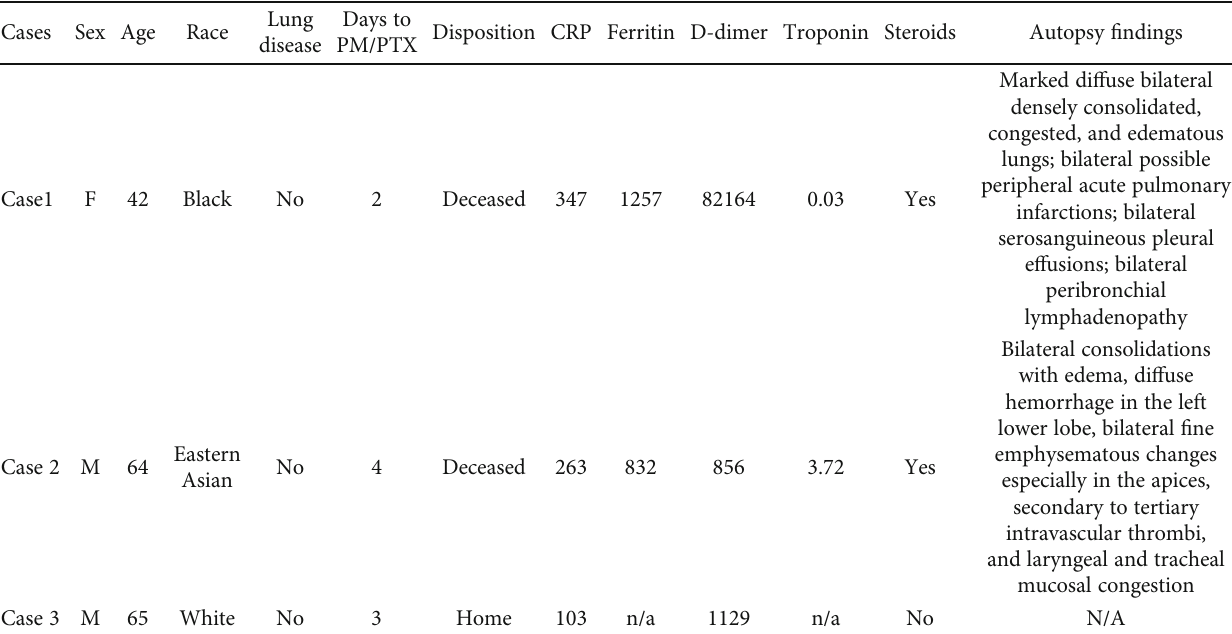
Table 1: Patient